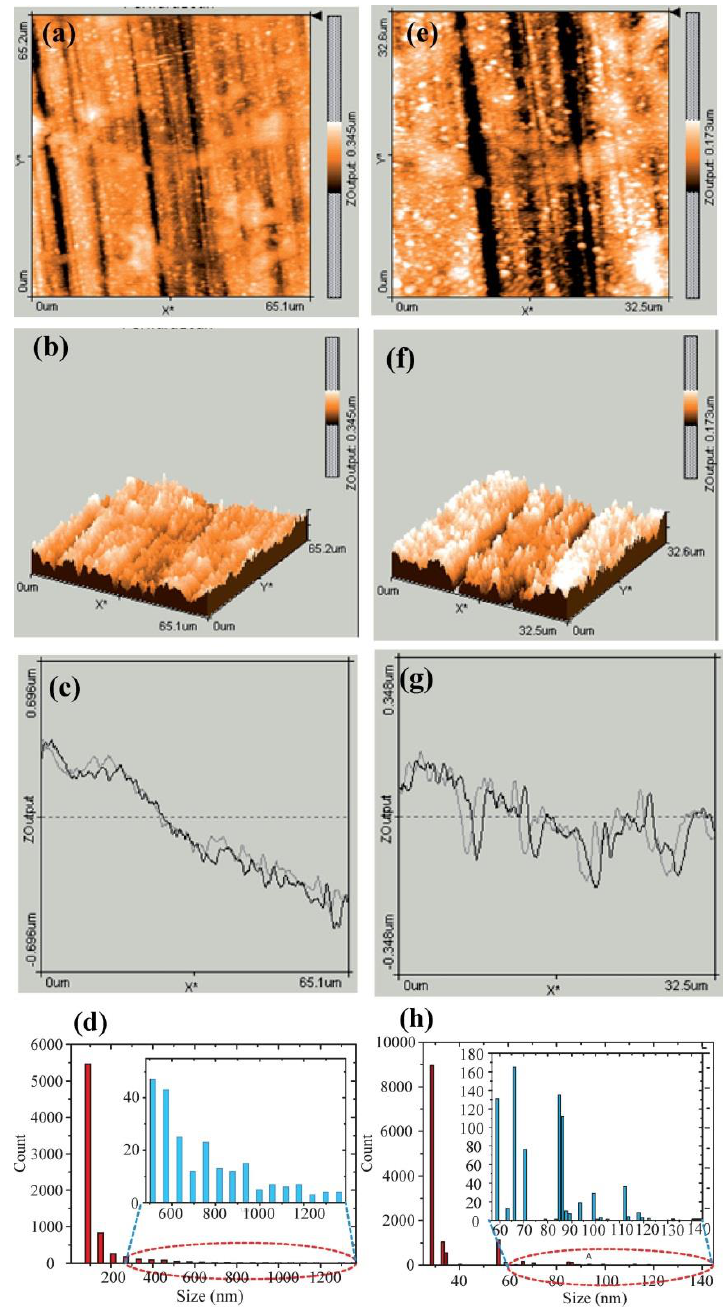
Figure 6. AFM images of the nanocluster deposited at a pressure, voltage, and current of 75 mbar, 0.19 kV, and 240 mA, respectively. ( a ) and ( b ) Two-dimensional and three-dimensional views of the low-resolution AFM scan of 65.1 µm × 65.2 µm. ( c ) and (g) AFM scan profile for low-resolution and high resolution s captured during AFM imaging. ( d ) Histogram of nanocluster size shown in ( a ) and ( b ). ( e ) and ( f ) Two-dimensional and three-dimensional views of the high-resolution AFM scan of 32.5 µm × 32.6 µm. ( h ) Histogram of nanocluster of a high-resolution AFM scan as shown in ( e ) and ( f ).